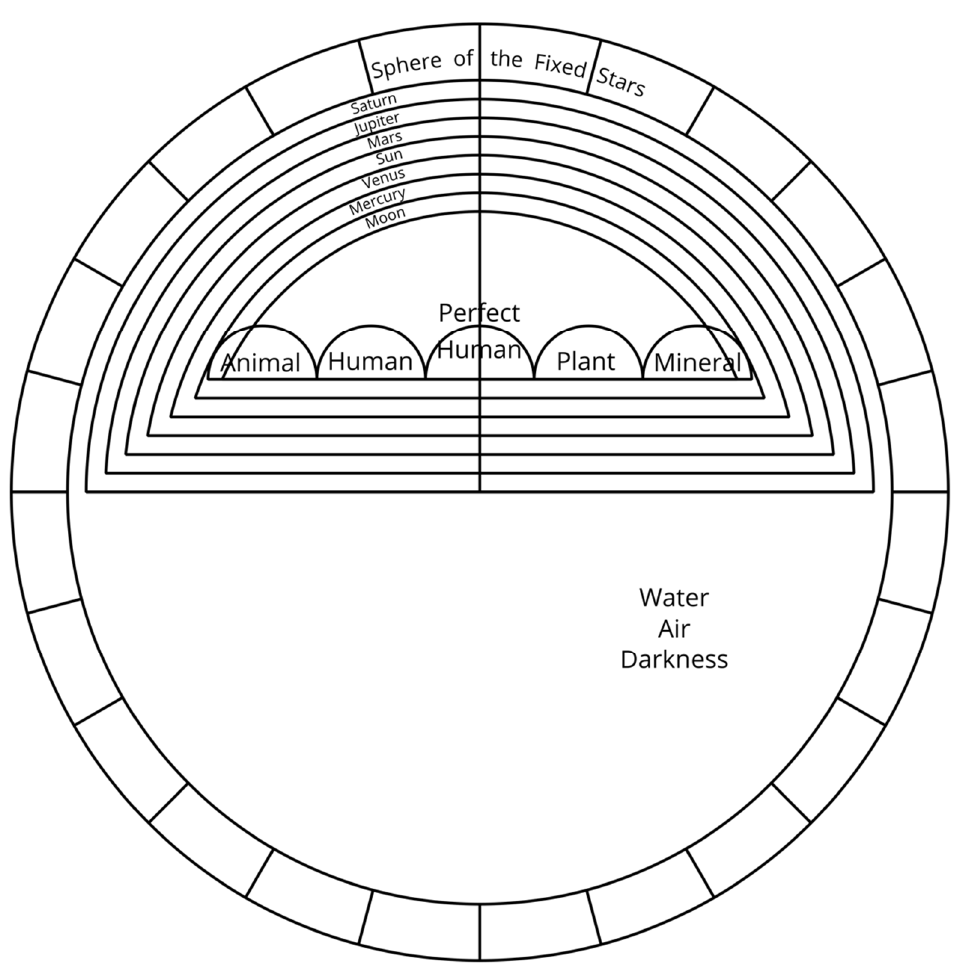
Figure 1. The heavenly spheres.